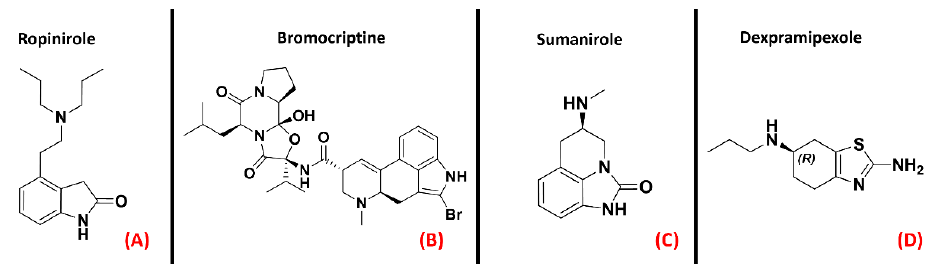
Figure 10. The chemical structures of the dopamine receptor agonists Ropinirole ( A ), which has an affinity for D2R, D3R, and D4R, Bromocriptine ( B ), also non-selective with an affinity for D2R, D3R, and D4R, and Sumanirole ( C ), selective for D2R. ( D ) Chemical structure of Dexpramipexole (its neuroprotective effects are attributed to dopaminergic-independent activities).